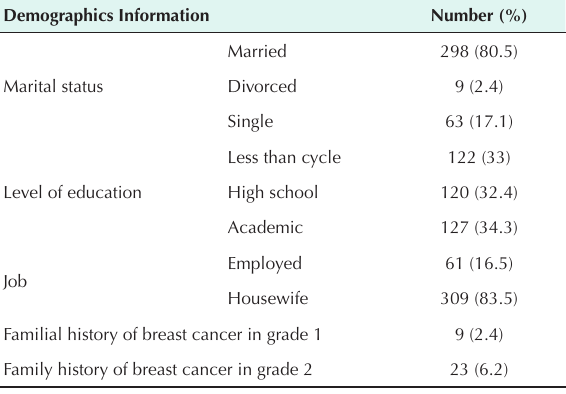
Table 1. Demographic Characteristics of Women Referring to Health Care Institutions of Bandar Abbas Demographics